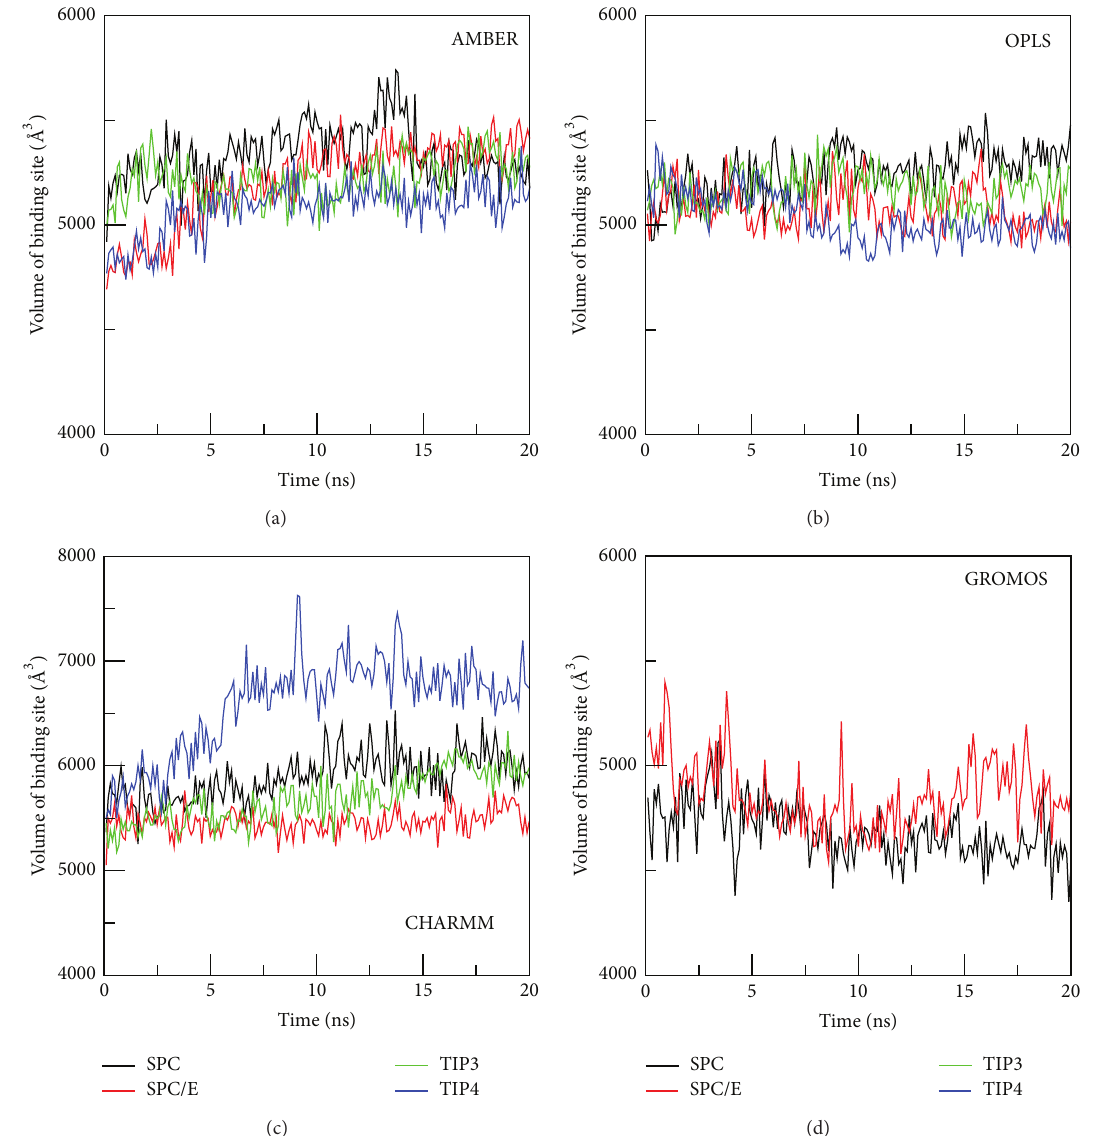
Figure 6: Time dependence of binding pocket volume in different force fields and water